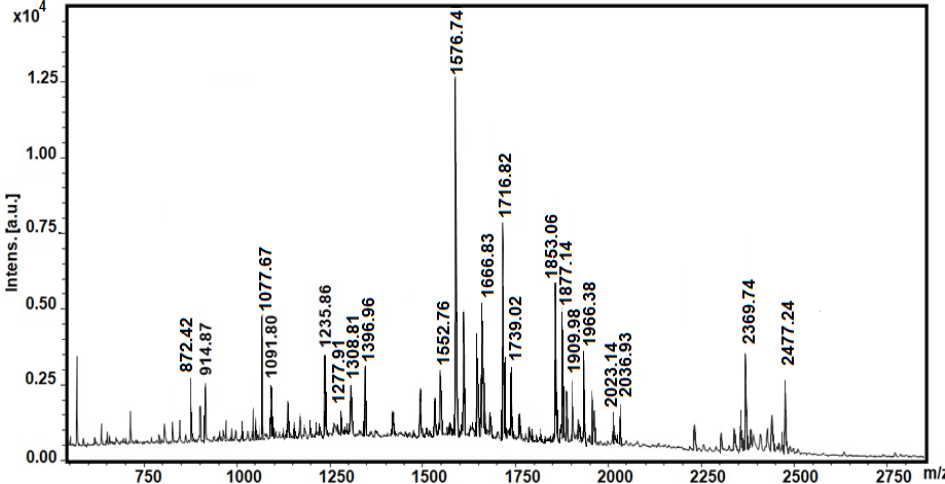
Figure 2. MALDI-MS spectrum of fraction with MW < 3 kDa. Standard peptide solution was used to calibrate the mass scale of the Autoflex™ III High-Performance MALDI-TOF and TOF/TOF Systems (Bruker Daltonics, Bremen, Germany).